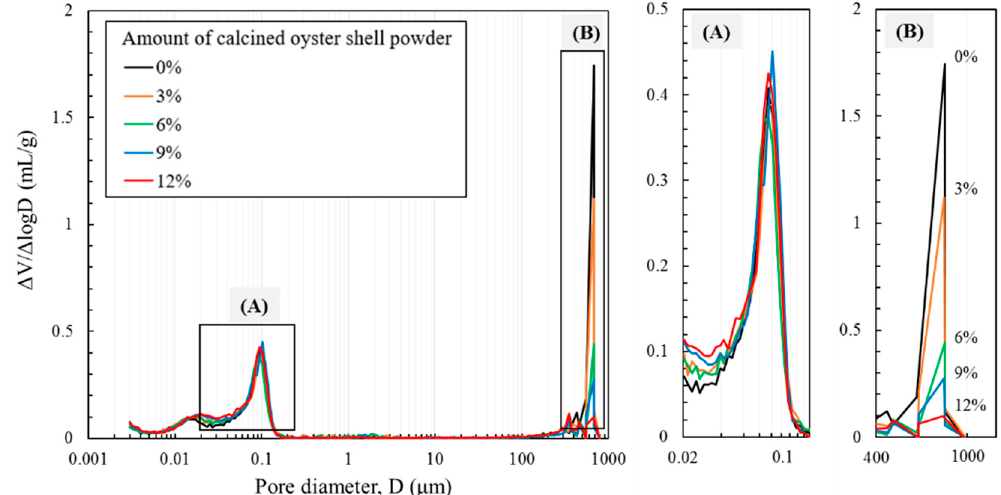
Figure 8. Pore size distribution (with pore size of 0.01 to 0.1 µ m ( A ) and 100 to 1000 µ m ( B )) of cement paste incorporating calcined oyster shell powder measured by mercury intrusion porosimetry